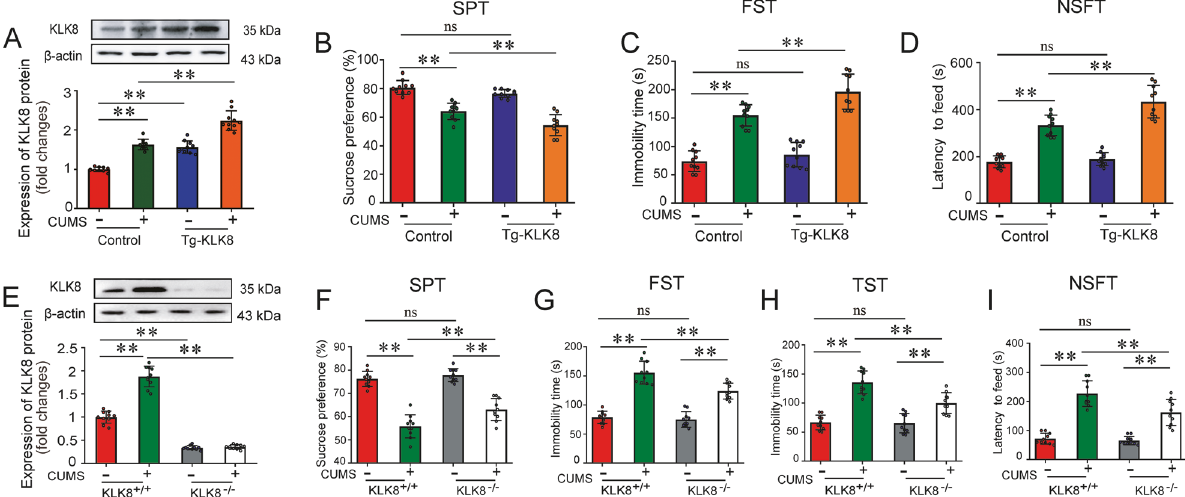
Fig. 2 Transgenic overexpression of KLK8 exacerbates, whereas KLK8 de fi ciency attenuates CUMS-induced depression-like behaviors. KLK8 transgenic (Tg-KLK8) rats or KLK8-de fi cient (KLK8 − / − ) mice were exposed to CUMS for 5 weeks. A , E Protein levels of KLK8 in the hippocampus of Tg-KLK8 rats ( A ) or KLK8 − / − mice ( E ) were determined by western blot analysis. Representative protein bands were presented on the top of the histograms. B – D Depressive behavioral tests were performed in CUMS-exposed control and Tg-KLK8 rats. B Indicated the SPT. C Indicated the immobility time in the FST. D Indicated the latency to feed in the NSFT. F – I Depressive behavioral tests were performed in CUMS-exposed wild-type and KLK8-de fi cient mice. F Indicated the SPT. G Indicated the immobility time in the FST. H Indicated the immobility time in the TST. I Indicated the latency to feed in the NSFT. Data were presented as means ± SD ( n = 10, two-way ANOVA, Bonferroni ’ s post hoc test). ** p < 0.01, ns not signi fi